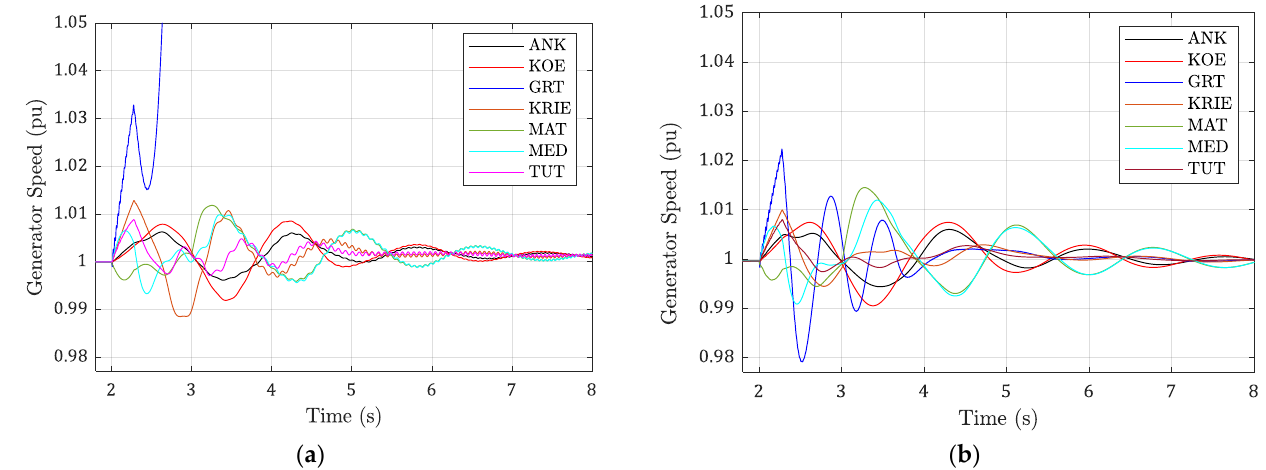
Figure 12. Angular speed for the synchronous generator ( a ) without the MTDC link and ( b ) with the MTDC link.